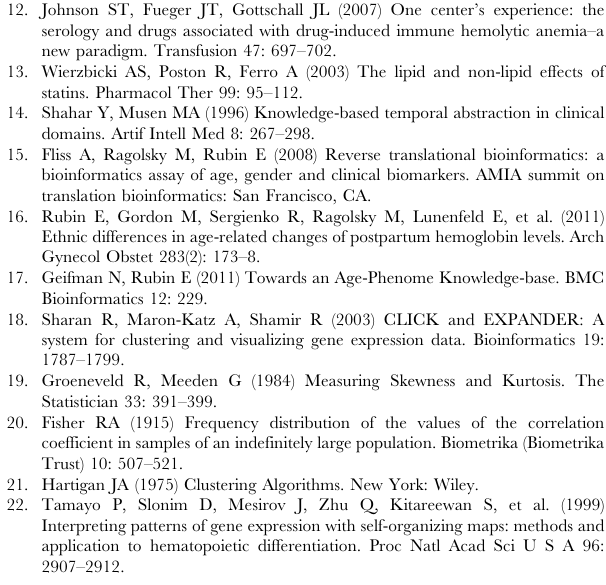
Table S3 Complete results of the enrichment